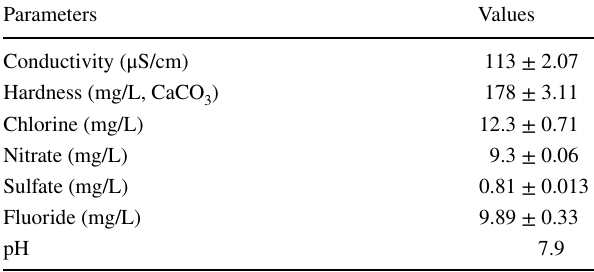
Table 6 Physico-chemical characteristics of ground